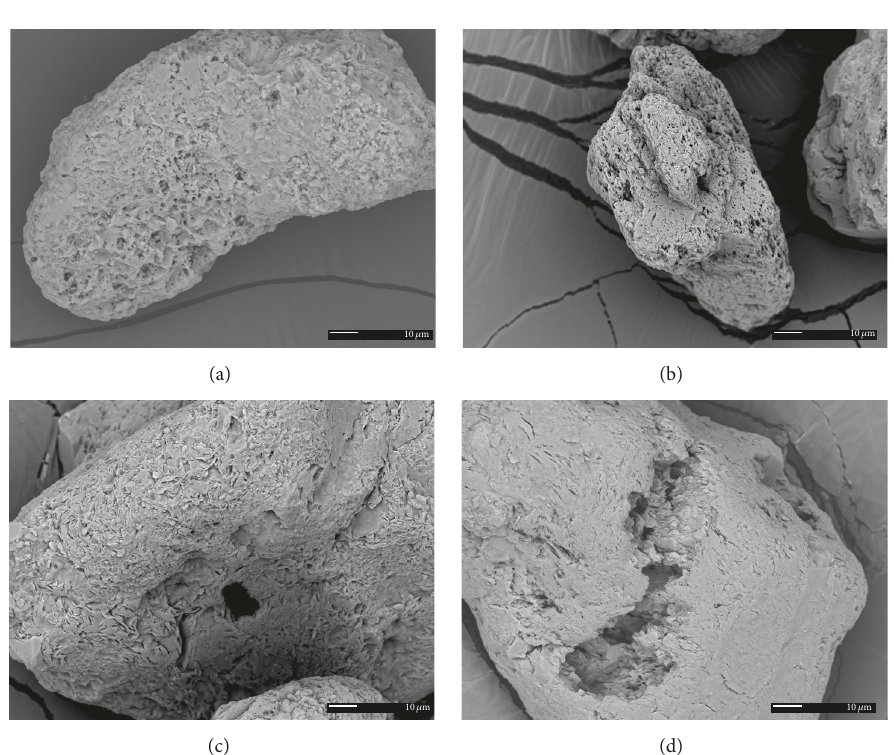
Figure 5: SEM electron backscatter images of the dissolved mineral surface by SO 2 -CO 2 -water interaction in the experiments: (a) K-Na plagioclase in 0.1% SO 2 case, (b) Na-plagioclase in 1% SO 2 case, (c) chlorite in 0.1% SO 2 case, and (d) chlorite in 1% SO 2